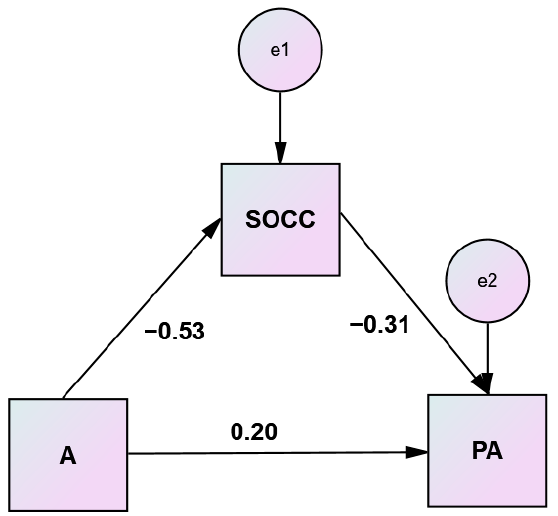
Figure 4. Simple mediation analysis of manageability (SOC C) on anger (A)–physical aggression (PA) relationship.